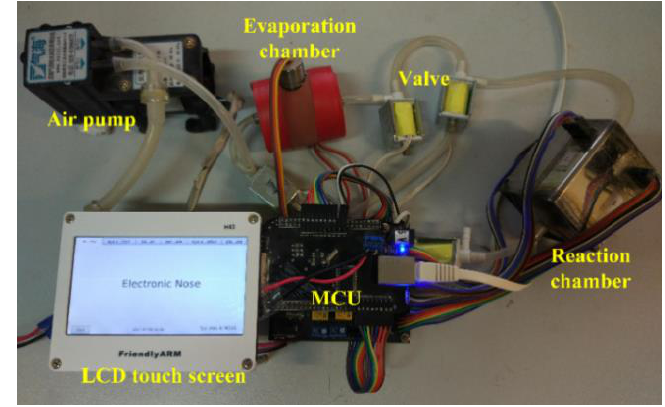
Figure 6. E-nose experiment platform.